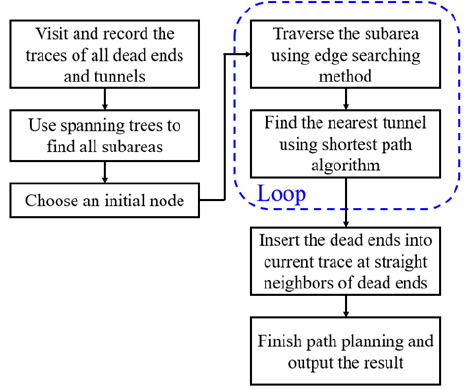
Figure 7. The generalized traversal path planning procedure using the edge searching method and shortest path algorithm.